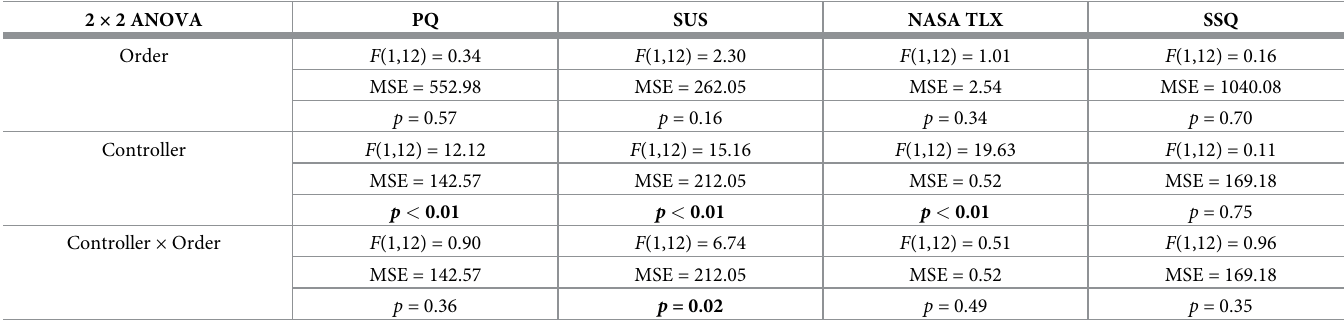
Table 1. Questionnaire results from Experiment 1. Significant results ( p < 0.05) are bold.